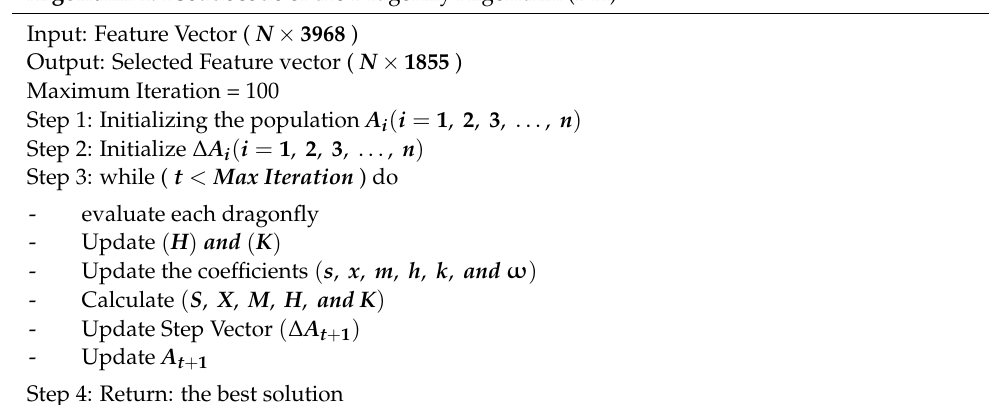
Algorithm 1: Pseudocode of the Dragonfly Algorithm (DA)